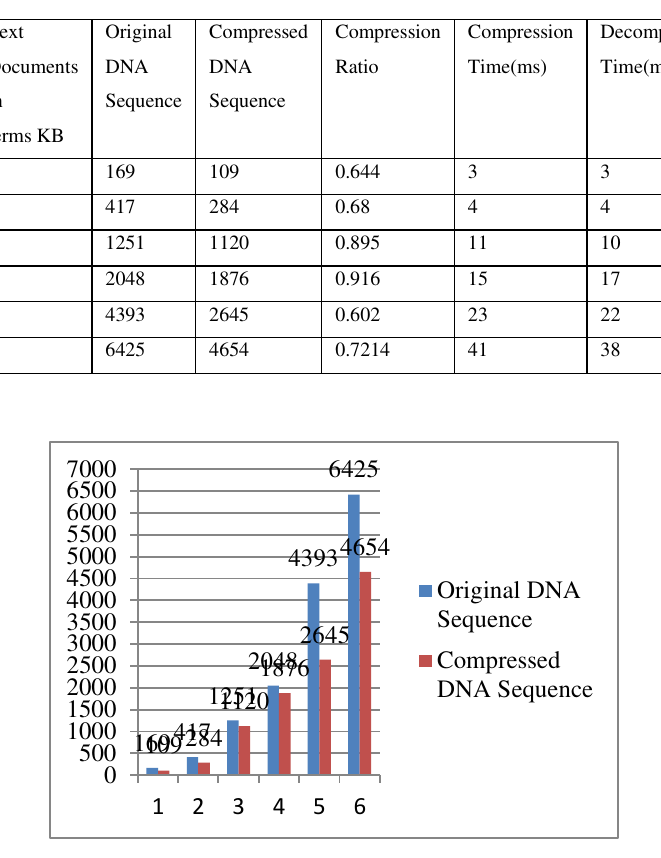
Figure 4 : Comparison of Conversion of Compressed to Original sequences with the